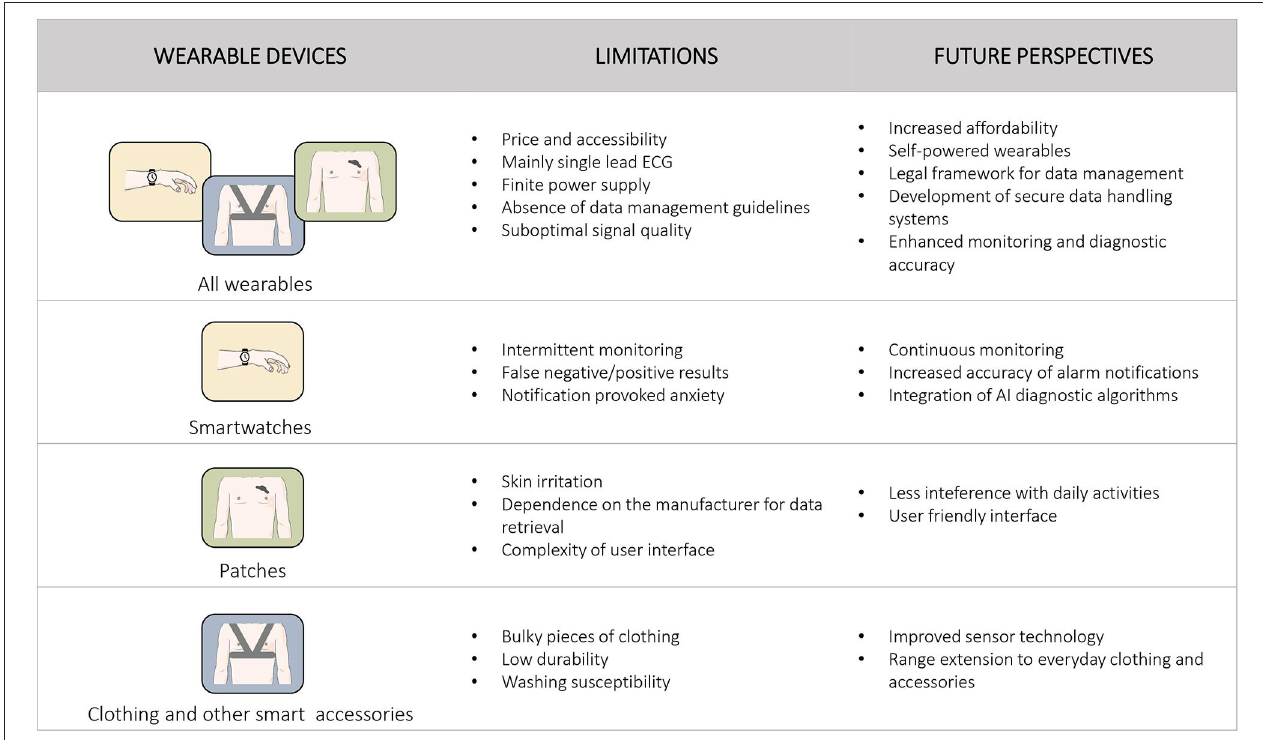
FIGURE 2 | Main limitations and future perspectives of wearable devices for heart rhythm monitoring are presented. Specific information for each category of wearable devices is presented